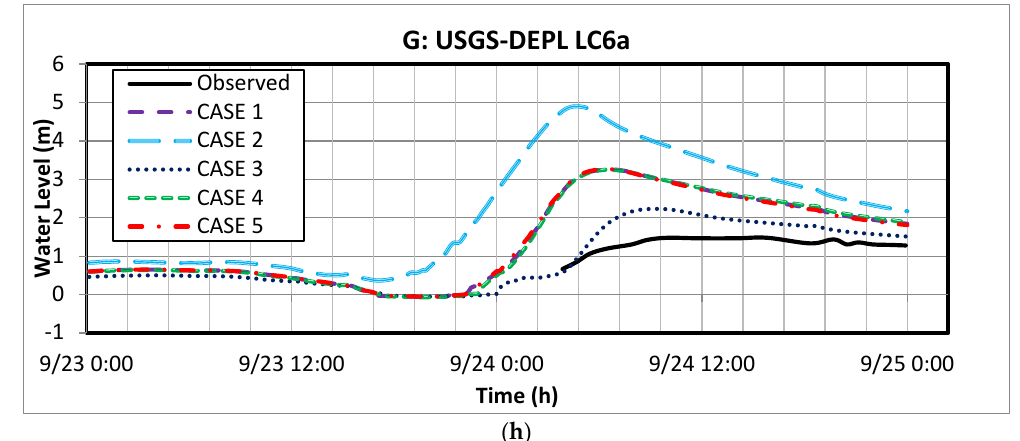
Figure 6. Effect of bottom friction and surface roughness: Observed and SWAN + ADCIRC modeled significant water level time series at different observation stations during the time of Hurricane Rita (9/23-25/05). ( a ) J—USGS-DEPL LF5; ( b ) H—USGS-DEPL LC8a; ( c ) I—USGS-DEPL LC9; ( d ) D—USGS-DEPL LA12; ( e ) F—USGS-DEPL LC13; ( f ) E—USGS-DEPL LA9; ( g ) C—USGS-DEPL LA10; ( h ) G—USGS-DEPL LC6a.